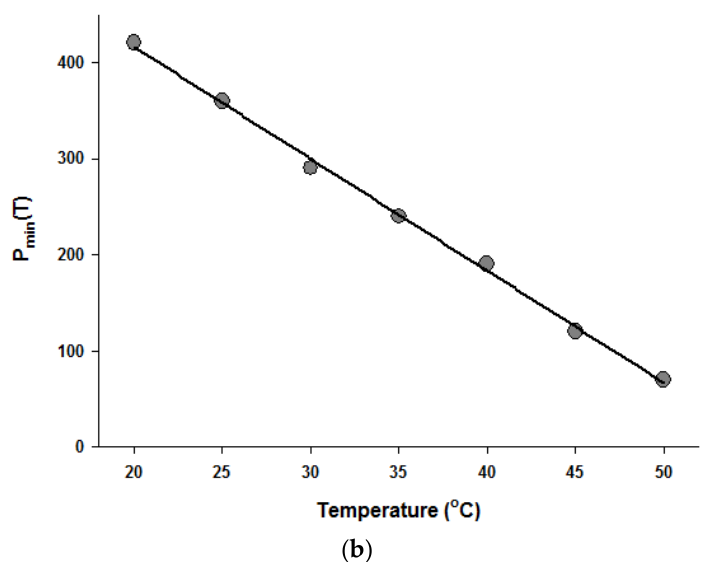
Figure 4. Temperature dependence of the parameters of the Fermi equation: k ( a ) and P min ( b ).